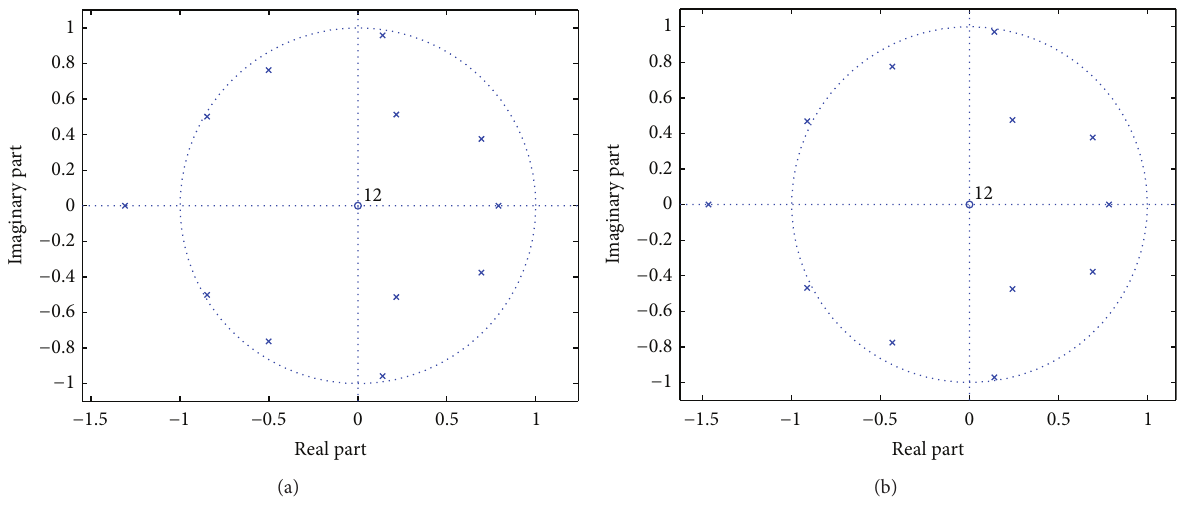
Figure 12: Mean Pole zero plots for vowel /o/ for person 2 for day 1 (left side) and day 2 (right